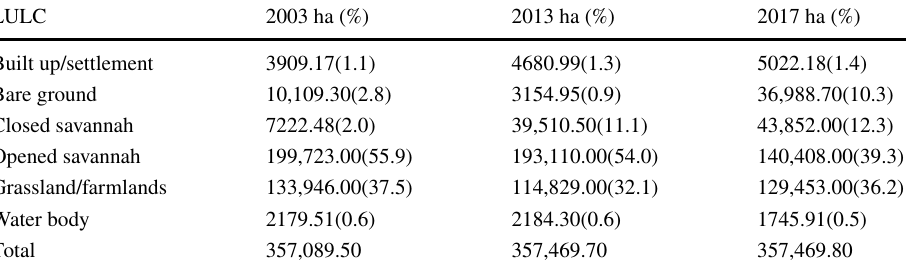
Table 1 Aerial coverage of LULC types in the Nawuni Catchment